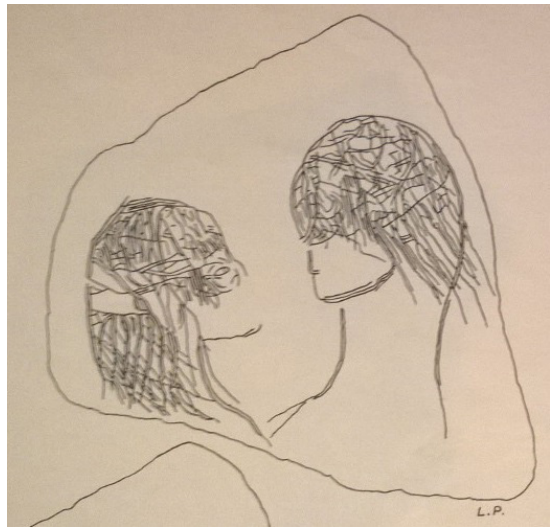
Figure 16. Group α, examples of Hand α6: Obs. 22(I-II) (from Pales,